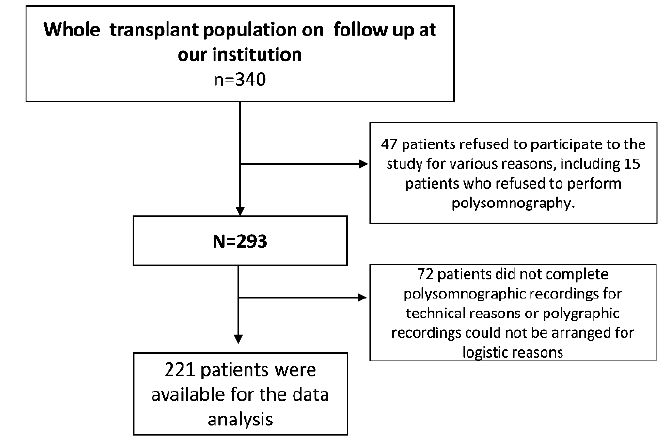
Figure 1. Flow chart of patients included in the study.